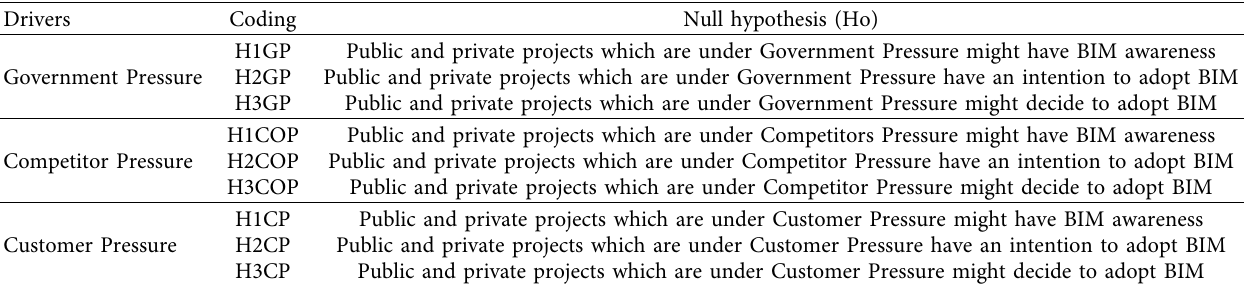
Table 4: Hypothesis about the effect of environmental aspects in public and private sectors across adoption stages.